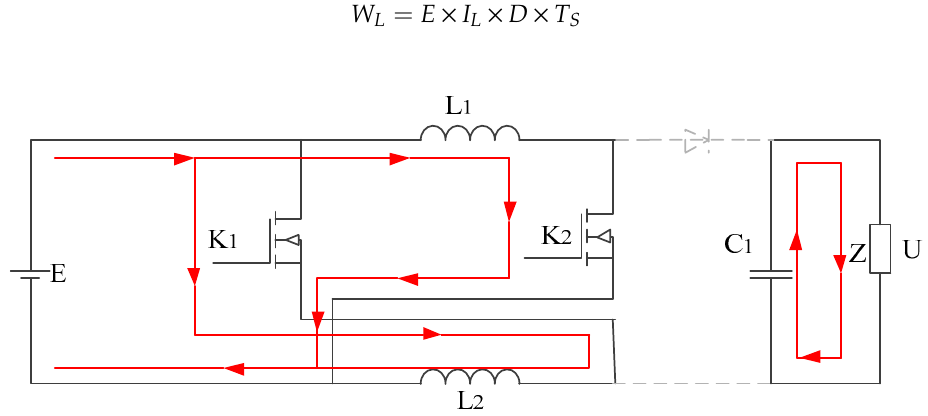
Figure 1. Dual-switch boost converter topology.